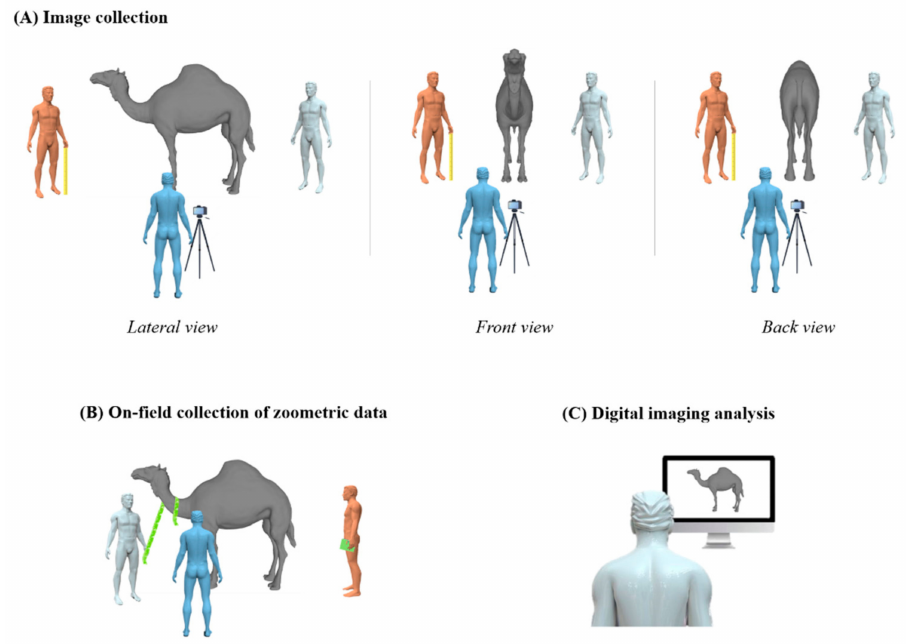
Figure 3. Graphic representation of the relative position of operators during across data collection phases. During ( A ) image collection, first operator (Grey) was responsible to hold camel on